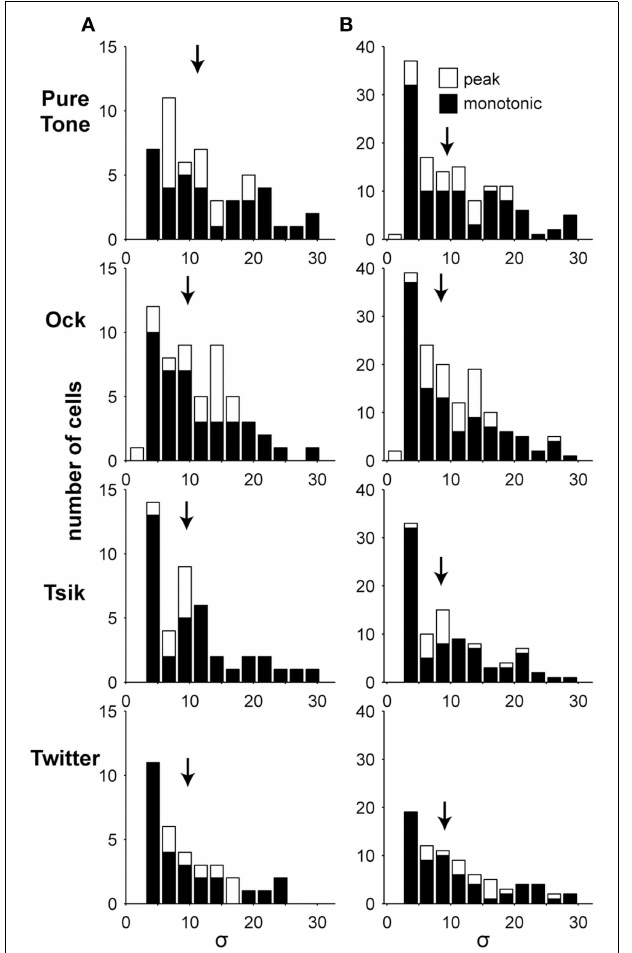
FIGURE 7 | Slope of ILD-response functions. Each column shows the distribution of the fitted parameter σ which indicates the slope of the ILD-response functions. (A) In the left column, only data from the ABL opt of significantly sensitive cells are illustrated, and hence there is a maximum of one data point from each cell. (B) In the right column, all significantly sensitive responses are shown, so there could potentially be three data points from each cell. Shading indicates the type of ILD-response function. Arrows indicate the medians of the distributions. No significant differences were found.